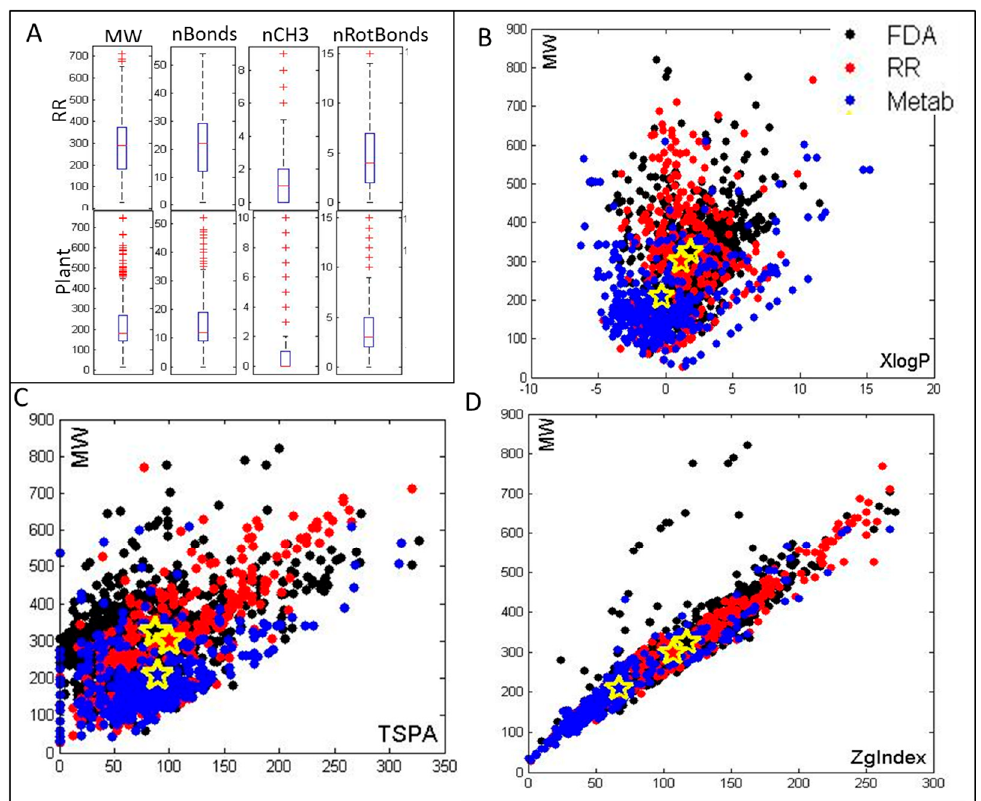
Figure 1. ( A ) Range of molecular sizes and structures in resistance-related (RR) metabolites, including the molecular weight (MW), the number of bonds (nBonds), the number of CH3 groups (nCH3), and the number of rotatable bonds (nRotBonds); ( B – D ) show values for Lipinski “rule-of-five” characteristics [42] of molecules in RR, plant metabolites (Metab), and FDA-approved drug (FDA) sets; ( B ) shows values of the logarithm of the partition coefficient for n-octanol/water LogP (XLogP) relative to MW; ( C ) topological polar surface area (TPSA) of molecules relative to MW and ( D ) Zagreb Index values (ZgIndex) relative to MW. Stars in ( B – D ) show the average values for all molecules in the group with black indicating FDA, red indicating RR, and blue indicating Metab. The larger similarity between RR and FDA molecules is apparent in all cases suggesting that RR metabolites have increased drug-like qualities, particularly in terms of passive membrane transport relative to average plant